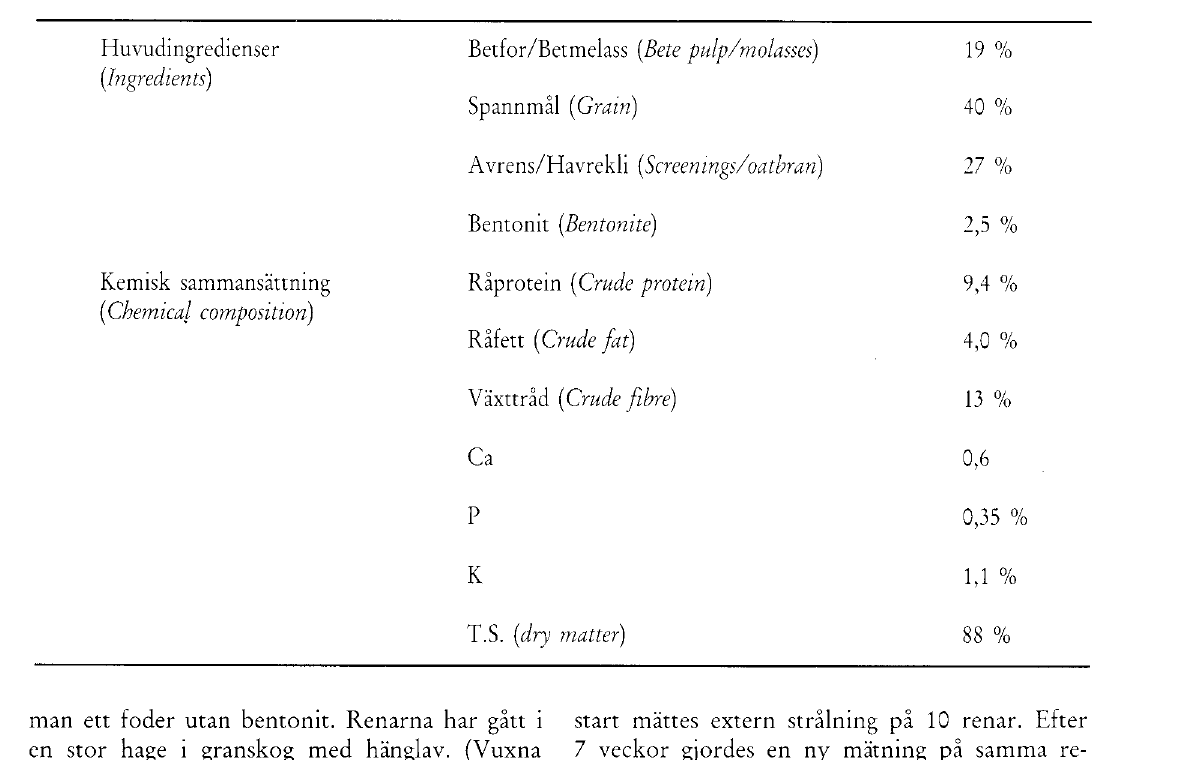
Table 3. Half-times for L37 Cs in reindeer from Gran (calves and adults) fed uncontaminated feed during two month, from November 1988 to January 1989. No caesium-binder was used during the first period. Du ring the last three weeks prior to slaughter feed containing 2,5 % of bentomte was